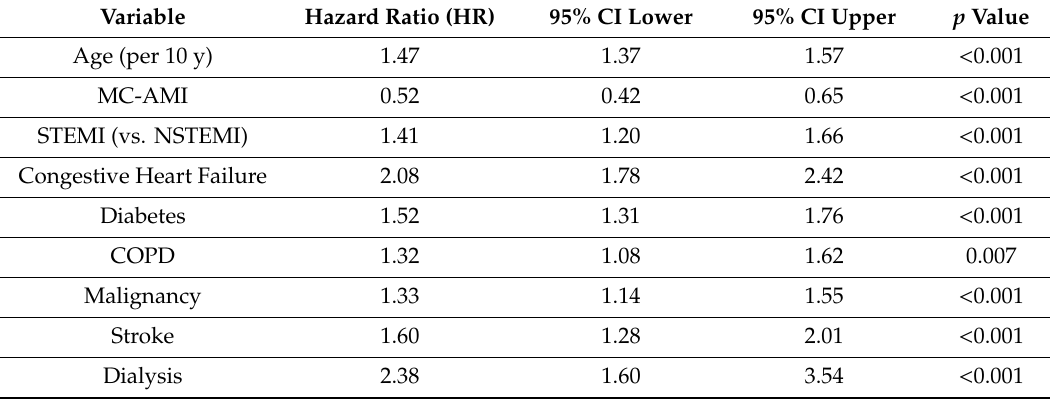
Table 3. Cox proportional hazards model—mortality in 12-month observation—matched population—variables included in the final model.